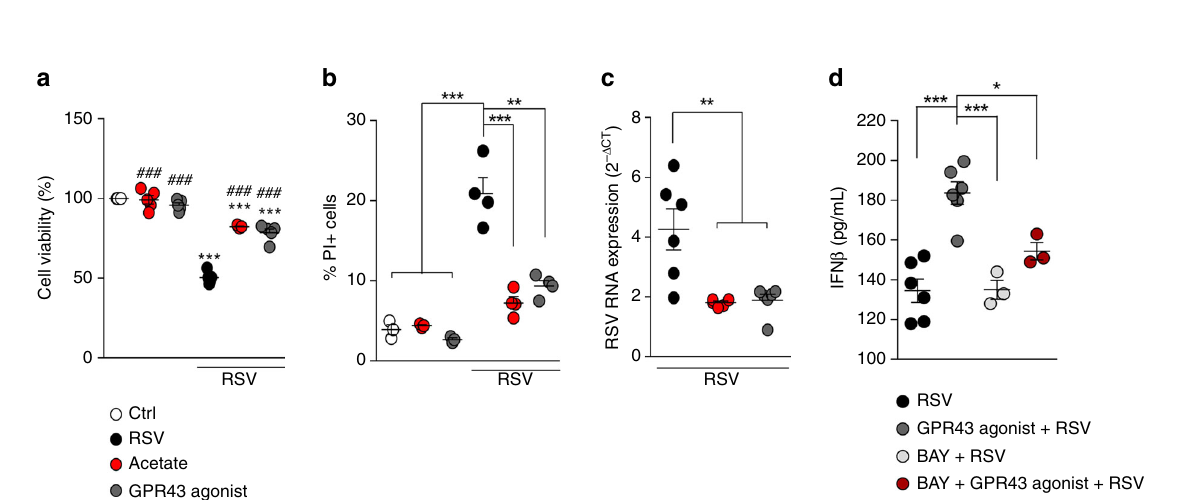
Fig. 8 Speci fi c activation of GPR43 protects against in vitro RSV infection. A549 cells were treated with 260 µ M acetate or a GPR43-synthetic agonist (10 µ M 4-CMTB) for 24 h and then infected with RSV (10 4 PFU/ml). Four days later response parameters were analyzed. a cell viability was accessed by MTT assay. b Percent of cell death was determined by PI staining. c RSV RNA levels were detected using real-time PCR (2- Δ Ct analysis). d Concentrations of IFN- β in the cell supernatant 12 h after infection were detected by ELISA. All data are expressed as mean ± SEM. Data in a and b are quadruplicate mean of two experiments. Data in c and d are sextuplicate mean of one experiment. Statistical signi fi cance was determined with Krukal-wallis. ** p < 0.01, *** p < 0.001. Data in b – d are provided as a Source Data fi